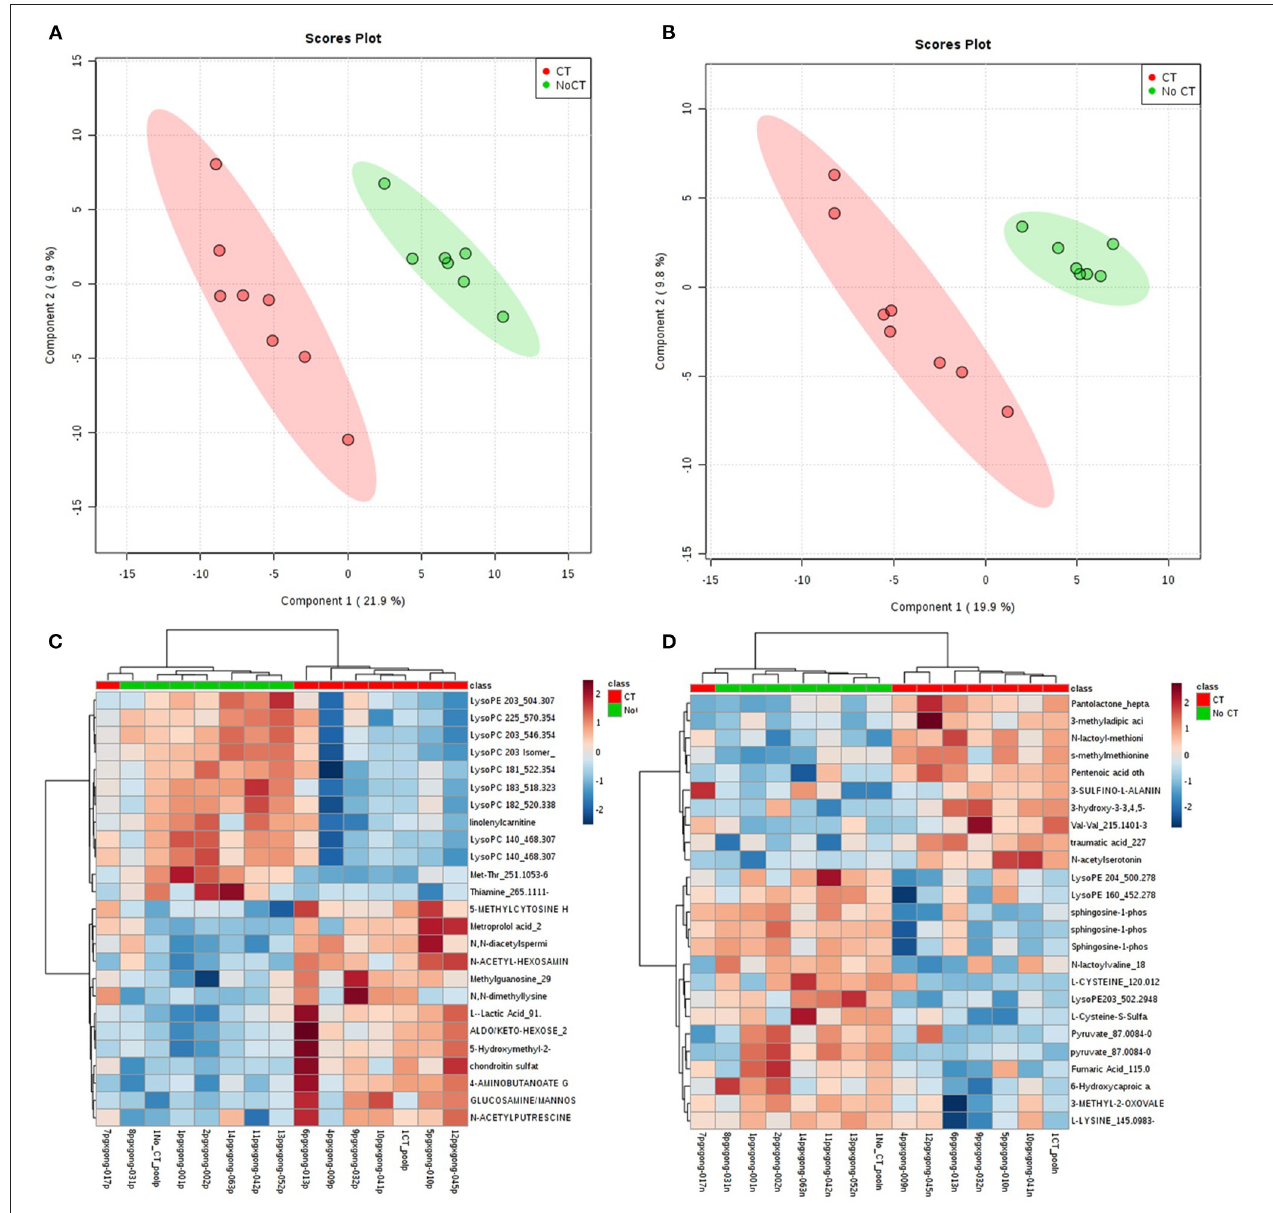
FIGURE 1 | Metabolomic profiling of MM patients treated with CFZ. Green color: patients without CVAE. Red color: patients with CVAE. (A) PLS-DA 2D scores plot of metabolites in the positive ion channel; (B) PLS-DA 2D scores plot of metabolites in the negative ion channel; (C) heatmap of the top 25 metabolites in the positive ion channel; (D) heatmap of the top 25 metabolites in the negative ion